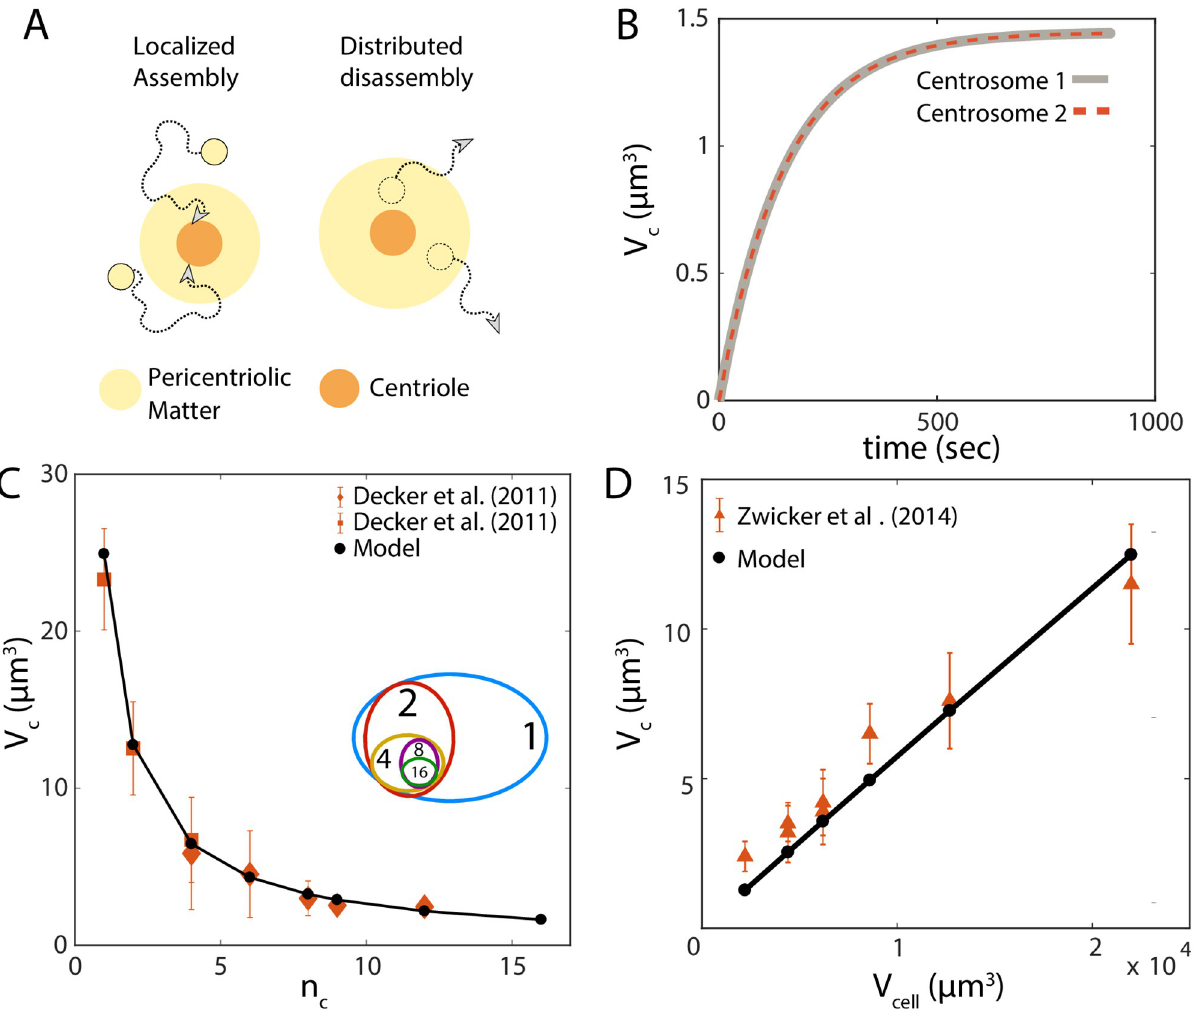
Fig 4. Centrosome growth by localised assembly and distributed disassembly. (A) Localized assembly around the centriole and disassembly throughout the pericentriolic matter generate a size-dependent disassembly rate which ensures robust size control. (B) Size dynamics of a pair of identical centrosomes that are initialized with equal size. Here V cell = 5000 μ m 3 (C) Centrosome volume decreases with increasing centrosome number, n c , during C. elegans embryonic development, where the embryo rapidly divides into many cells with decreasing cell size. Model: solid black line, Experimental data: orange. (D) Centrosome volume, V c , scales linearly with cell volume, V cell . Parameters: subunit concentration = 1.67 μ M, α = 0, β